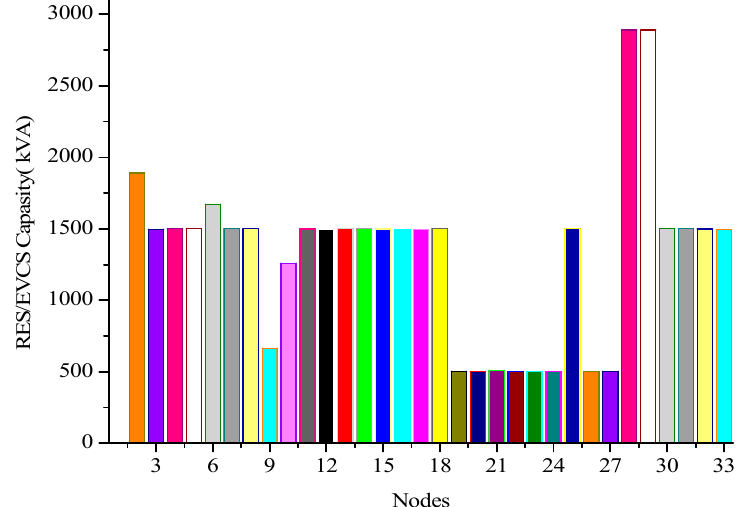
Figure 1. RES and EVCS capacity using a fuzzy logic approach.